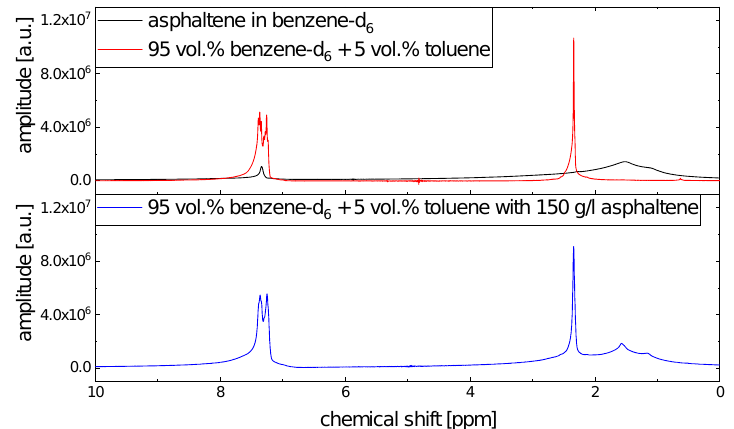
Figure 5. Example for the signal overlap of maltene and asphaltene protons. Top: 1 H-NMR spectra of the asphaltene in benzene-d 6 and the asphaltene-free toluene solution. Bottom: 1 H-NMR spectrum of the asphaltenic toluene solution. The ppm scale of the red and blue spectra is calibrated to the toluene CH 3 signal at 2.34ppm. Since the aromatic signal in the black spectrum results not only from the asphaltene, but also from non-deuterated benzene molecules (see Section 4.2), the ppm value of this signal is set to 7.34ppm. The amplitudes were normalized by the number of scans used to acquire the spectrum. ( a ) Longitudinal relaxation.